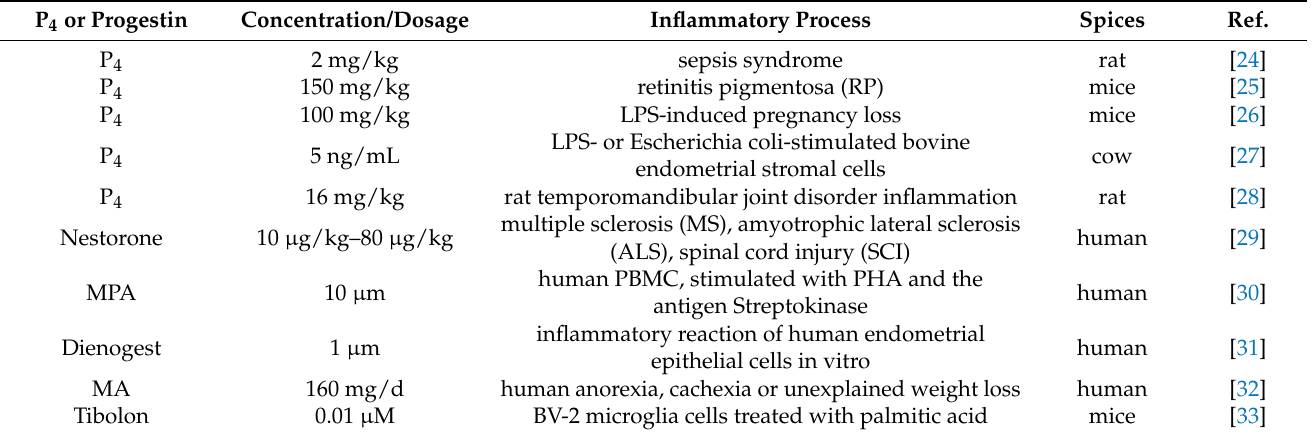
Table 1. The examples of anti-inflammatory action of progesterone and progesterone- related drugs on different human and animal